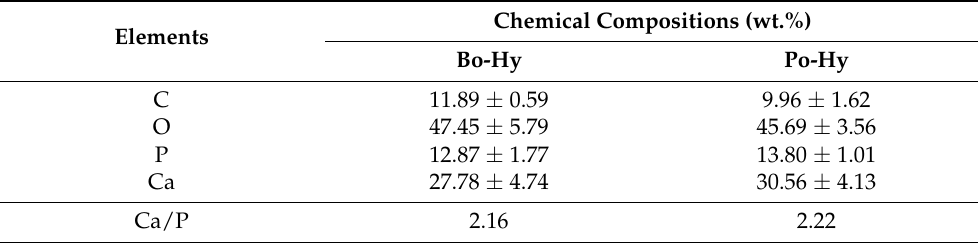
Figure 5. Comparative SEM images of experimental xenografts. ( a ) Bo-Hy and ( b ) Po-Hy. The figure clearly demonstrates macro-porous characteristics and comparable structures of two xenografts. Table 2. Elemental chemical compositions of the two xenograft composites using EDX (atomic %, mean ± SD).